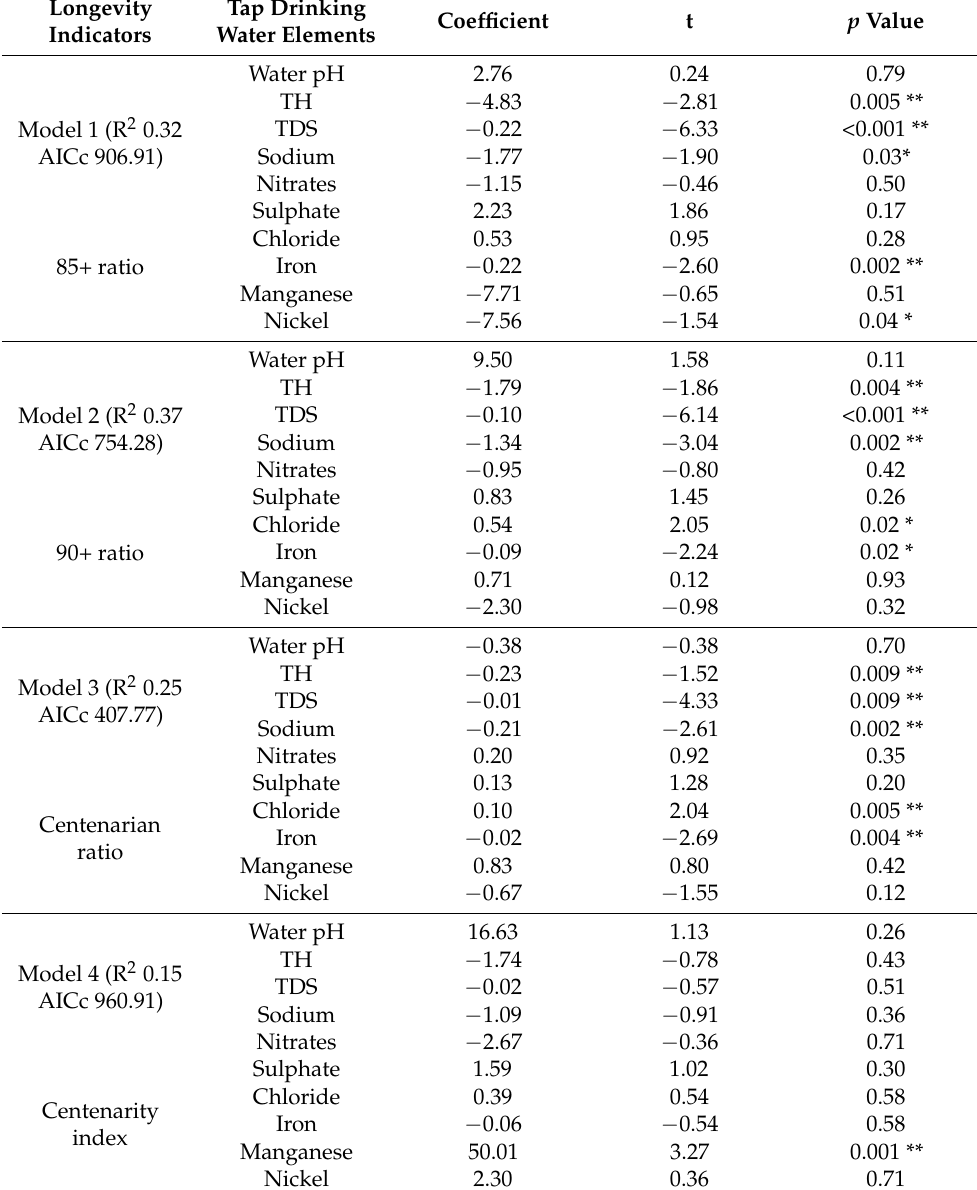
Table 3. Results of OLS